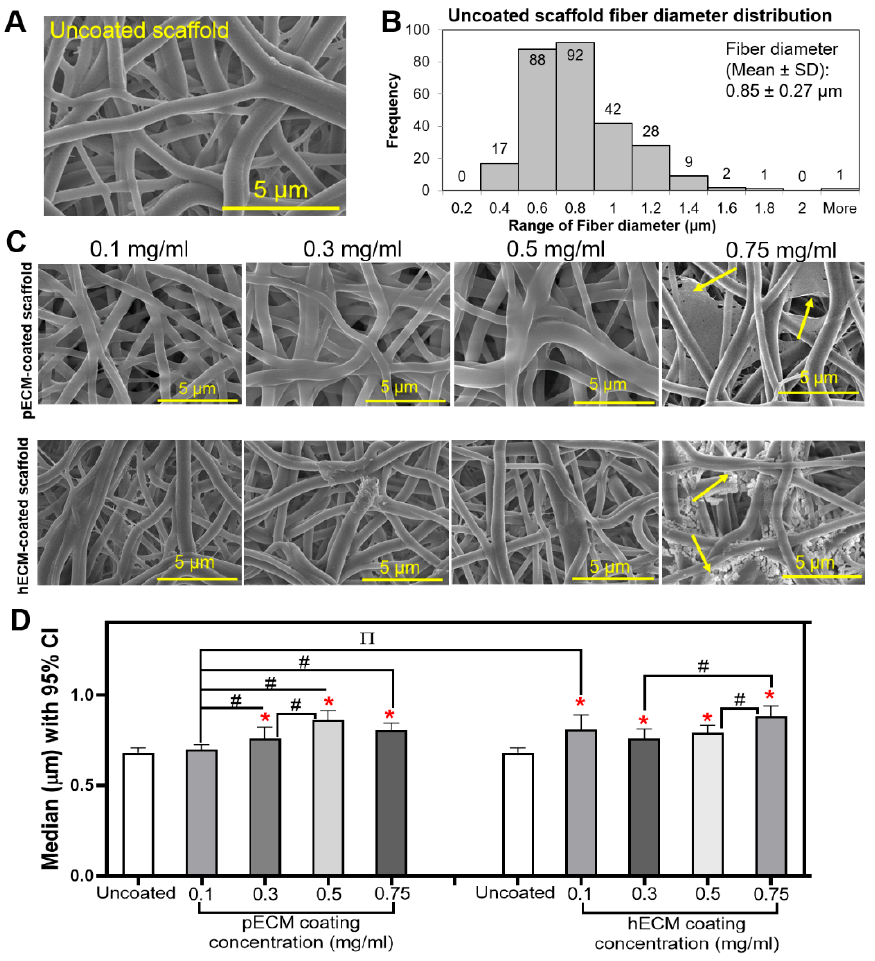
Figure 1. Characterization of the tracheal scaffolds. ( A ) SEM image of syn-TG. ( B ) Fiber diameter distribution (frequency) of uncoated syn-TG (distributions of the coated scaffolds are not shown). ( C ) SEM images of scaffolds coated by 0.1-, 0.3-, 0.5-, and 0.75-mg/mL pECM and hECM. Arrows denote hydrogel formation in pECM and hECM 0.75-mg/mL-coated fibers. ( D ) Median diameter (µm) of the fibers with a 95% confidence interval (CI). * Represents the differences of all the coating groups, except pECM 0.1 mg/mL, compared with the uncoated scaffold ( p = 0.0011 for pECM (0.3); p = 0.0064 for hECM (0.3); p < 0.0001 for pECM (0.5 and 0.75); and hECM (0.1, 0.5, and 0.75)). # Represents the differences between different concentrations within the same coating type ( p = 0.0477 for pECM (0.1) vs. (0.3), p < 0.0001 for pECM (0.1) vs. (0.5), p < 0.0001 for pECM (0.1) vs. (0.75), p = 0.0052 for pECM (0.3) vs. (0.5), p = 0.0001 for hECM (0.3) vs. (0.5), and p = 0.0041 for hECM (0.5) vs. (0.75)). ∏ Represents the differences between the different coating types, pECM and hECM, within the 0.1-mg/mL concentration ( p = 0.0003).